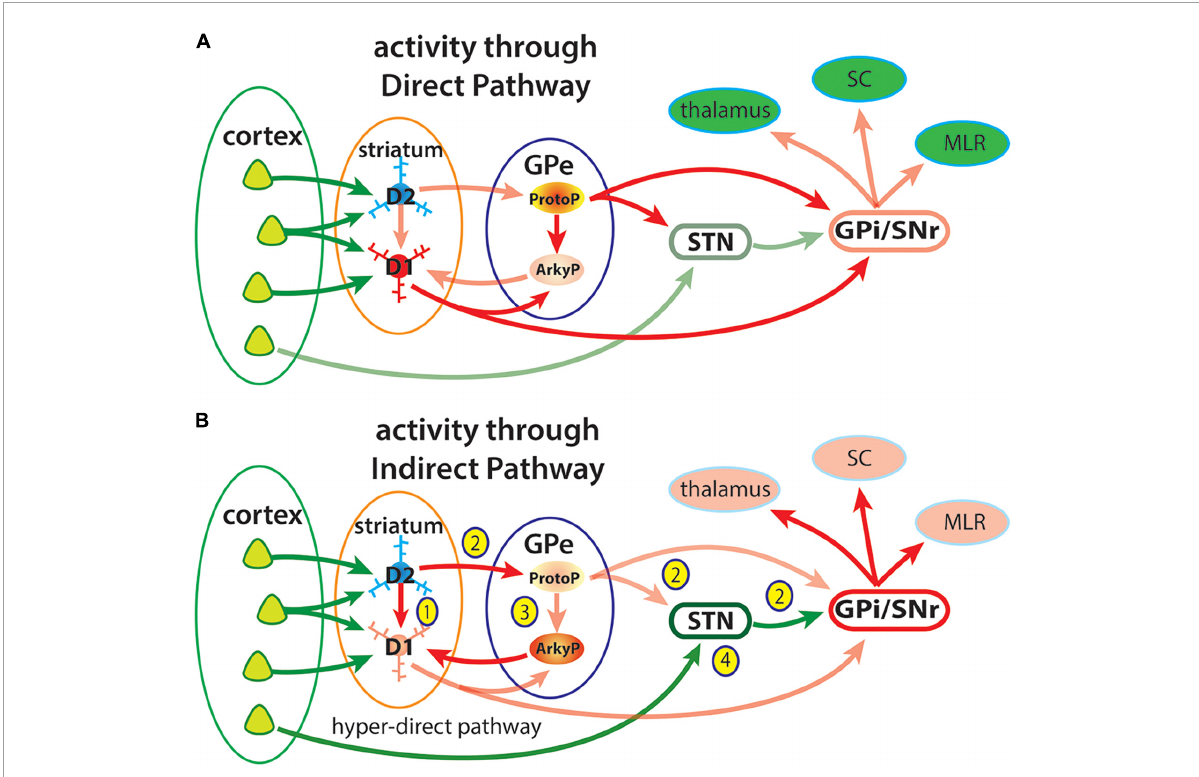
FIGURE7 Diagram of simplified view of activity through the direct and indirect pathways highlighting some connections of the GPe. Cortical neurons provide excitatory inputs to D1r- or D2r-expressing SPNs that give rise to the direct and indirect striatal pathways to the output pathways of the basal arising from GABAergic neurons in the GPi and SNr. These output neurons are tonically active, providing inhibitory input to circuits engaged in movement including the thalamus, superior colliculus (SC) and midbrain locomotor region (MLS). (A) Activity through the direct pathway: Cortical excitatory input to dSPNs (D1) provides direct inhibition of GPi/SNr neurons to disinhibit their targets in the thalamus, superior colliculus (SC) and midbrain locomotor region (MLR) (Chevalier et al., 1985). Prototypical GPe neurons are tonically active and provide inhibitory inputs to the subthalamic nucleus (STN) and GPi/SNr, which also contribute to disinhibition of basal ganglia targets. (B) Activity in the indirect pathway may have opponent effects on the direct pathway at multiple sites. (1) iSPNs may directly inhibit activity of neighboring dSPNs through collateral axons (Czubayko and Plenz, 2002; Taverna et al., 2008; Matamales et al., 2020). (2) The original indirect pathway circuit involves activity of iSPNs provide inhibition of prototypical GPe (ProtoP) neurons, which are tonically active, resulting in disinhibition of the STN and increased inhibition of basal ganglia targets (Pamukcu et al., 2020). (3) iSPN inhibition of ProtoGPe neurons also disinhibits Arkypallidal (ArkyP) neurons, which provide inhibitory inputs selectively to dSPNs resulting in suppression of movement (Aristieta et al., 2021; Cui et al., 2021a,b). (4) The hyper-direct pathway from the cerebral cortex directly to the STN provides an additional mechanism to increase the inhibitory output of the basal